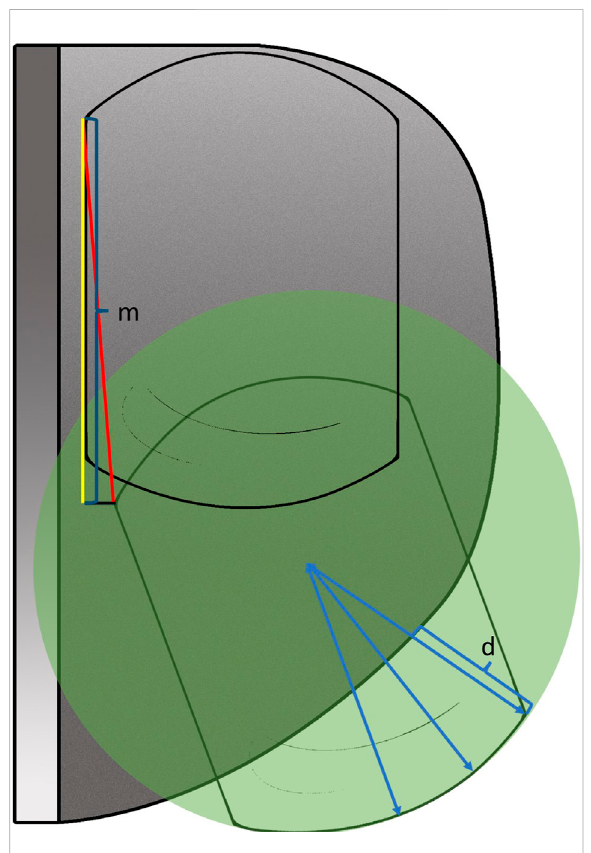
FIGURE 3 Diagram of the extrusion distance (d) and moving distance (m) of the meniscus